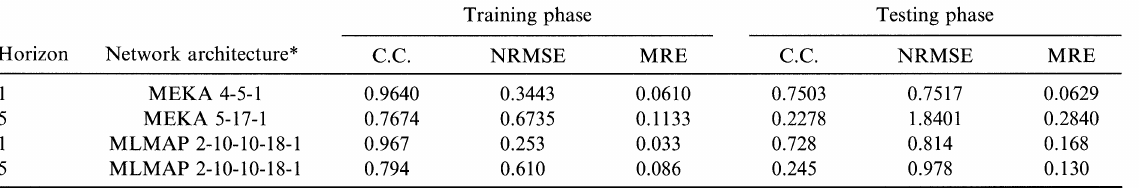
TABLE II Evaluation of interest-rate prediction during the training and testing phases for a one and five-days prediction